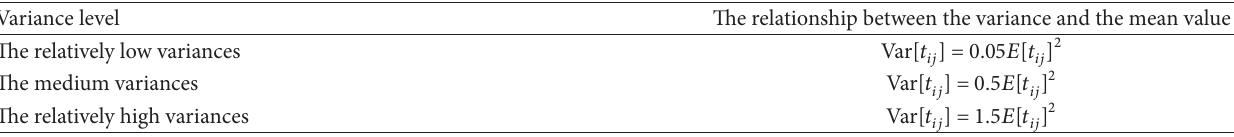
Table 1: The relationship between the variance and the mean value for each variance level.